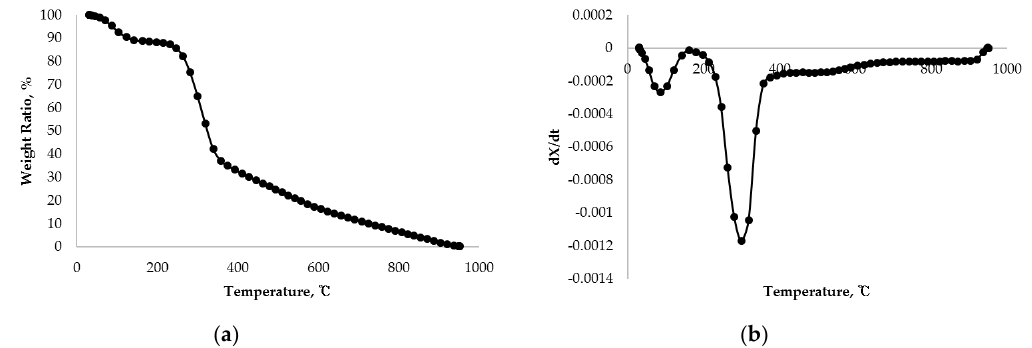
Figure 4. TGA results for sawdust. ( a ) TG curve; ( b ) DTG (Derivative TG) curve.